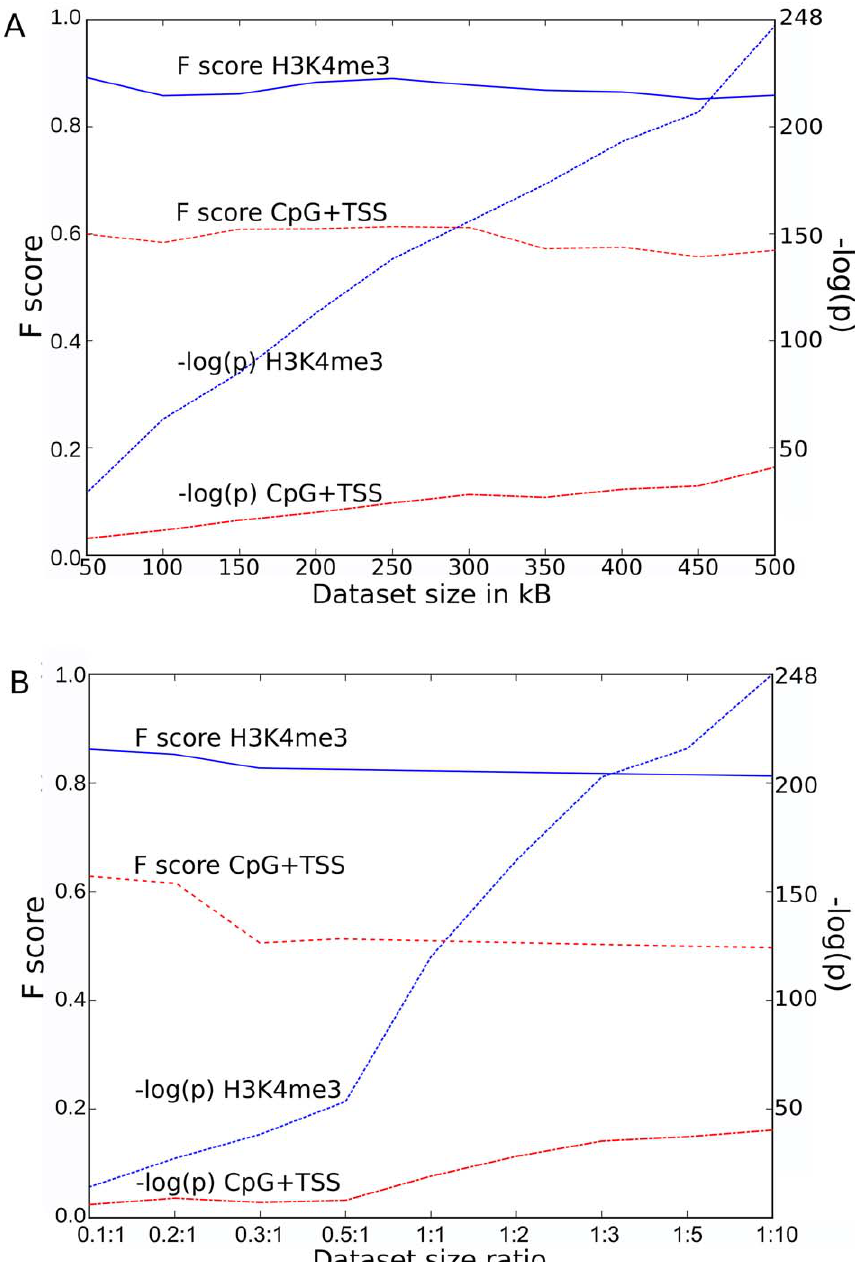
Figure 6. Stability of F score as function of dataset size. ( A ) Plot of the absolute value of the p-value exponent (right Y scale) or the F score (left Y scale) for H3K4me3 or CpG + TSS, as a function of MLV provirus dataset size. The experimental MLV dataset size (x-axis) was reduced by random sampling and the ratio of control dataset points was fixed at 10. ( B ) Examination of the same parameters as a function of the ratio between experimental and control dataset size (x-axis). The experimental dataset size was reduced by random sampling from 1:1 down to 0.1:1. From 1:1 up to 1:10 the control dataset size was proportionally increased by matched random generation.